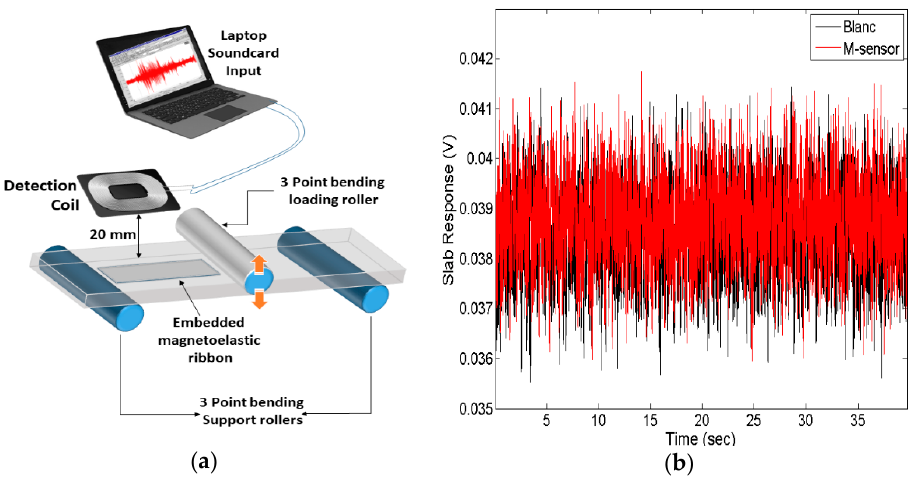
Figure 3. ( a ): DMA oscillation of smart type-A and -A blanc slabs. ( b ): Response of type-A, and A blanc slabs (in V) versus time.